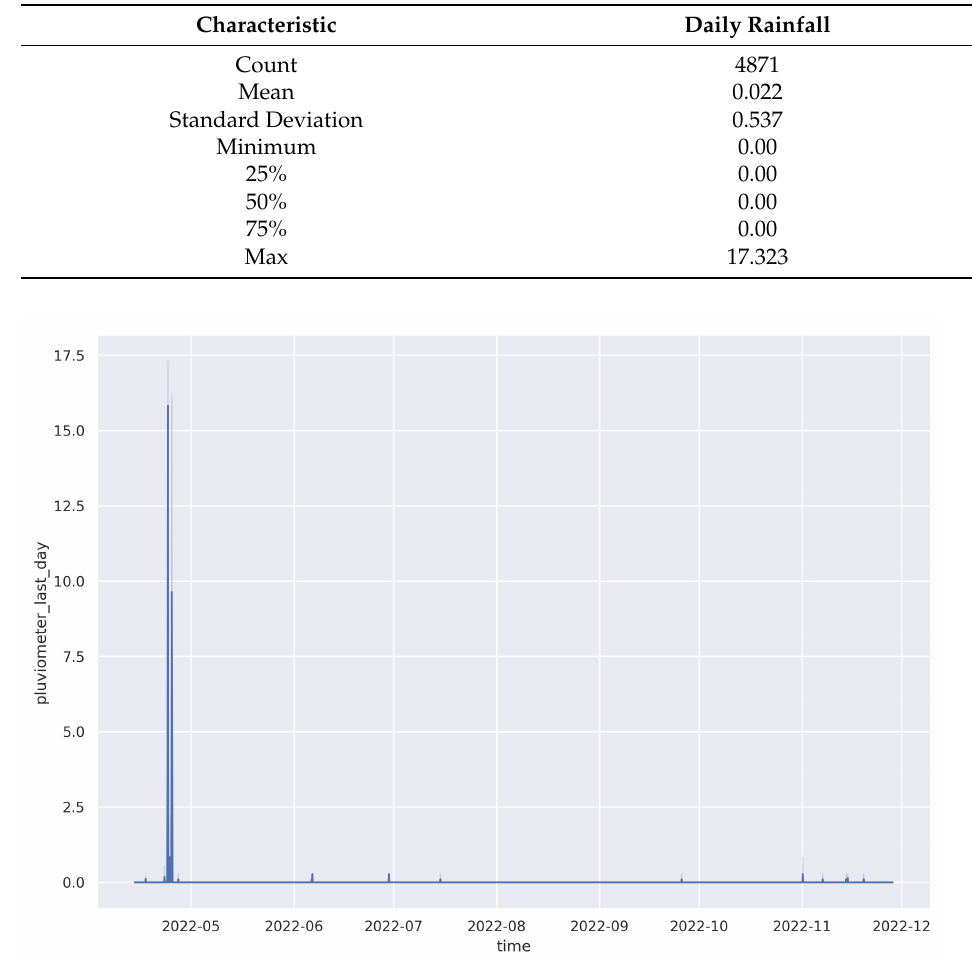
Figure 15. Daily rainfall trend from April to November